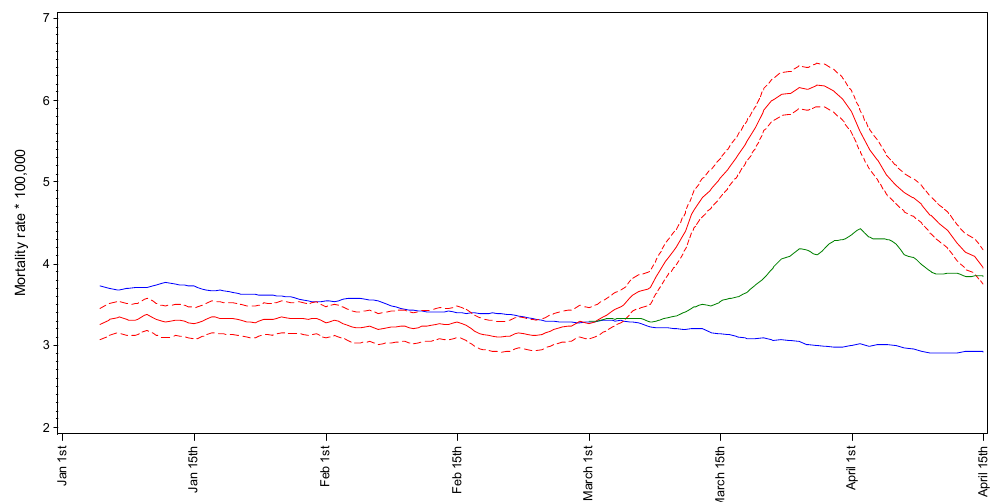
Figure 1. Daily mortality rates (5-day moving average) in the total sample population (red lines: mean and 95% confidence interval) and in the average of 2015–2019 periods (blue line), and COVID-19 mortality rates (green line).